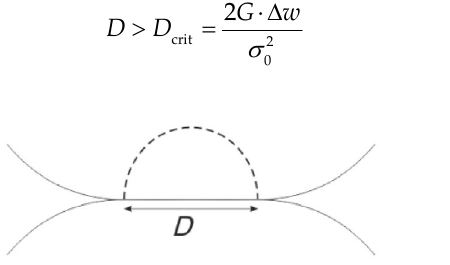
Fig. 1 Welded joint of size D created due to impact and consecutive shear of two